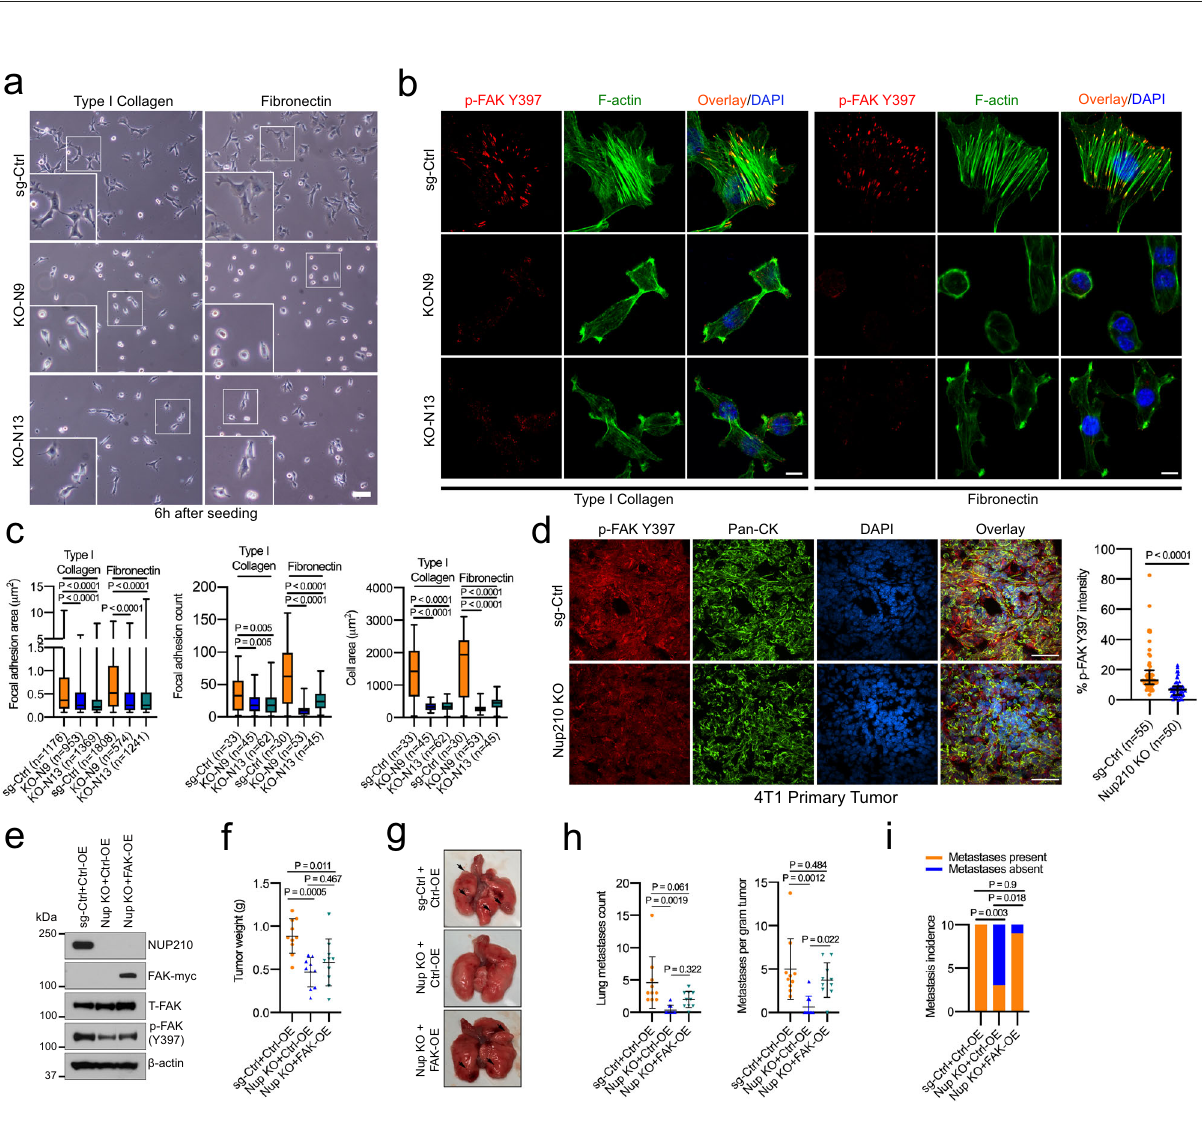
Fig. 6 Nup210 regulates focal adhesion of tumor cells. a Representative bright fi eld images of 4T1 Nup210 KO cells on type I collagen and fi bronectin. Scale bar = 100 μ m. b Representative images of p-FAK (Y397) focal adhesions and F-actin in sg-Ctrl and Nup210 KO cells on type I collagen and fi bronectin. Scale bar = 10 μ m. c Quanti fi cation of focal adhesion area, count, and cell spreading in sg-Ctrl and Nup210 KO 4T1 cells. ANOVA with Tukey ’ s multiple comparison correction. The box represents the 25th to 75th percentile, whiskers represent data range, and the horizontal line represents the median. d (Left) Immunostaining of Nup210 KO (KO-N13) 4T1 primary tumors with p-FAK Y397 and pan-cytokeratin (Pan-CK) antibodies. Scale bar = 50 μ m. (Right) quanti fi cation of p-FAK Y397 signal in the Pan-CK-stained tumor area. N = 5 mice per condition, ~10 independent fi elds per mouse tumor section. Mann – Whitney U test, median with interquartile range. e Western blot of myc-tagged FAK overexpression in Nup210 KO 4T1 cells. f Primary tumor weight in FAK-overexpressing Nup210 KO (KO-N13) 4T1 cells. ANOVA with Tukey ’ s multiple comparison correction, mean ± s.d. n = 10 mice per group. g Representative lung images of the mice injected with FAK-overexpressing Nup210 KO cells. h Lung metastasis count and metastases normalized to tumor weight in FAK-overexpressing Nup210 KO cells. ANOVA with Tukey ’ s multiple comparison correction, mean ± s.d. n = 10 mice per group. i Metastasis incidence in mice injected with FAK-overexpressing Nup210 KO cells. χ 2 test with Bonferroni correction. n = 10 mice per group.